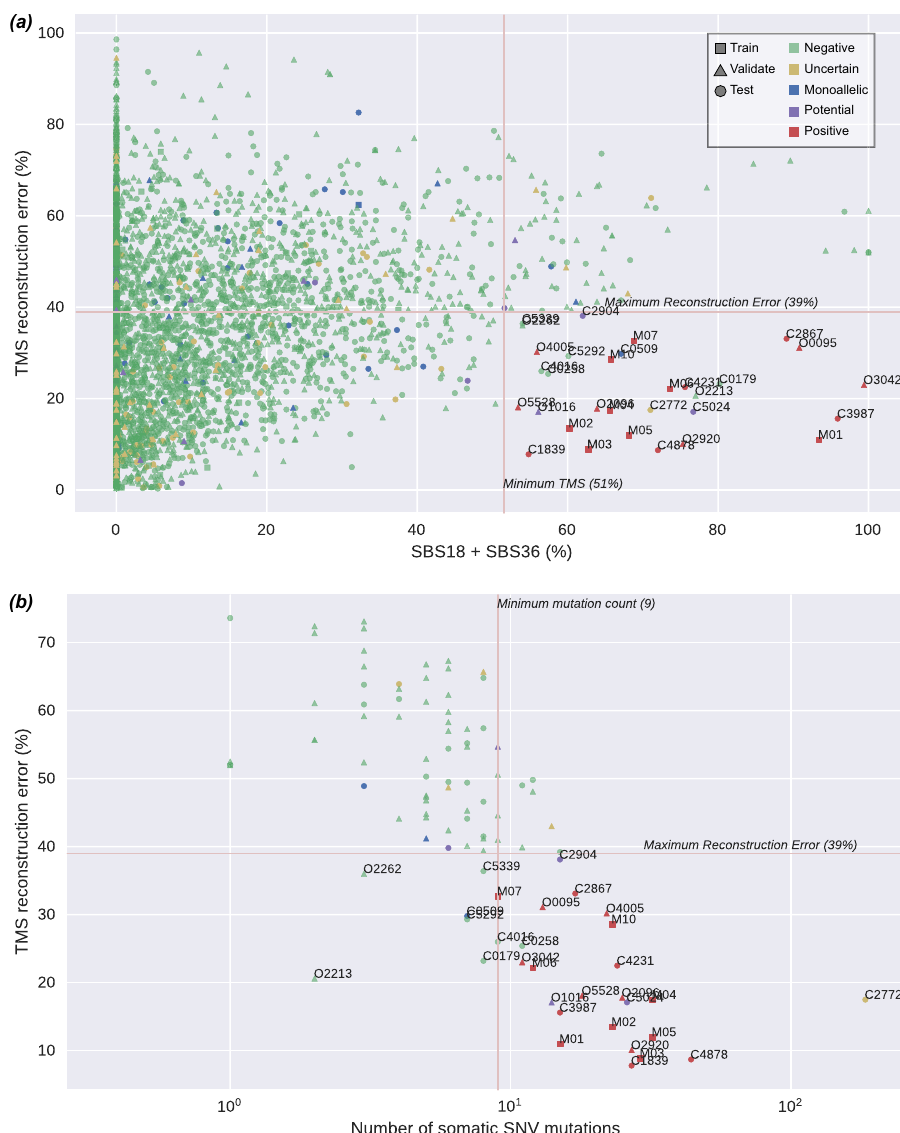
Fig. 4 Distribution of SBS18/SBS36, somatic single nucleotide variants (SNVs), and tumor mutational signature (TMS) reconstruction error across CRCs from training, validation, and test sets. a The CRCs from the biallelic MUTYH pathogenic variant carriers cluster together based on high SBS18/ SBS36 TMS and low TMS reconstruction error highlighting the need to include TMS reconstruction error in classi fi er, and b CRCs with greater than 95% likelihood of arising from biallelic MUTYH pathogenic variants based on TMS. The number of SNV mutations used in determining TMS (horizontal axis) and the TMS reconstruction error (vertical axis) demonstrates the importance of low reconstruction error (<39%) and suf fi cient somatic mutation count ( ≥ 9) for correctly classifying tumors from biallelic MUTYH pathogenic variant carriers (true positives). Source data are provided as a Source Data fi